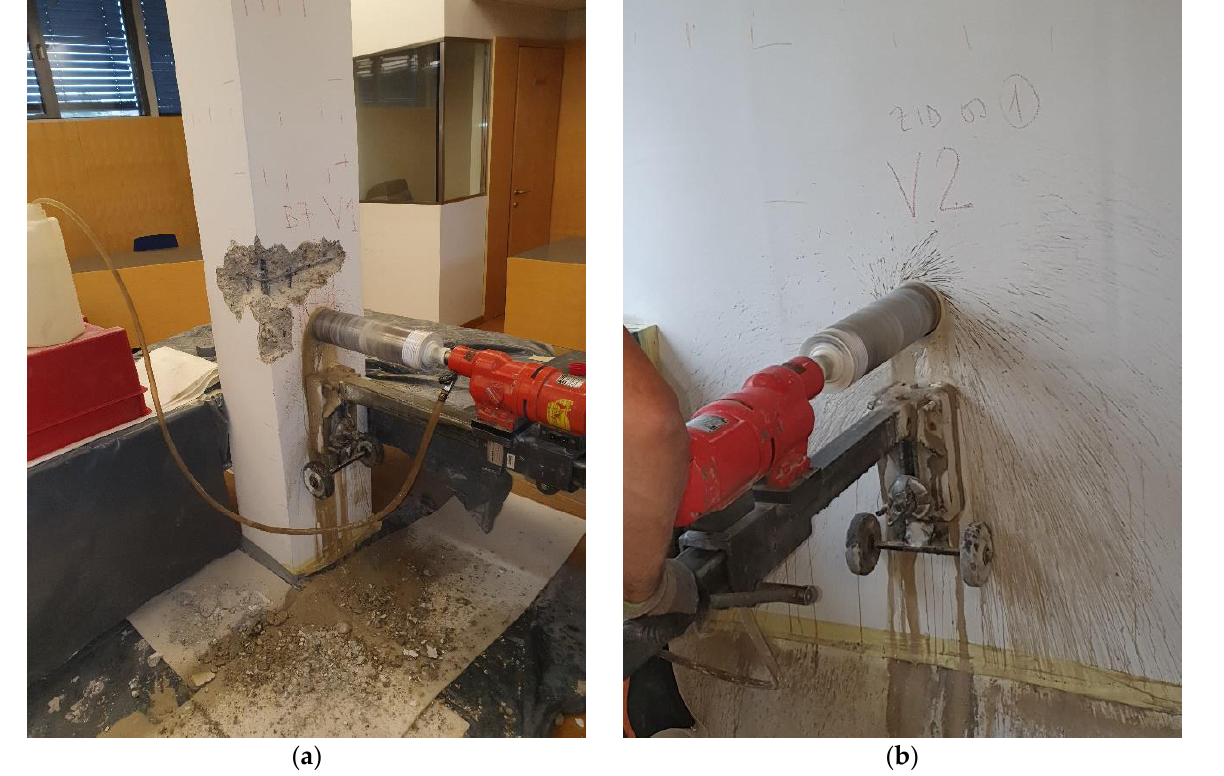
Figure 9. Extracting concrete samples in the column on the ground floor ( a ) and a wall on the 2nd floor ( b ).